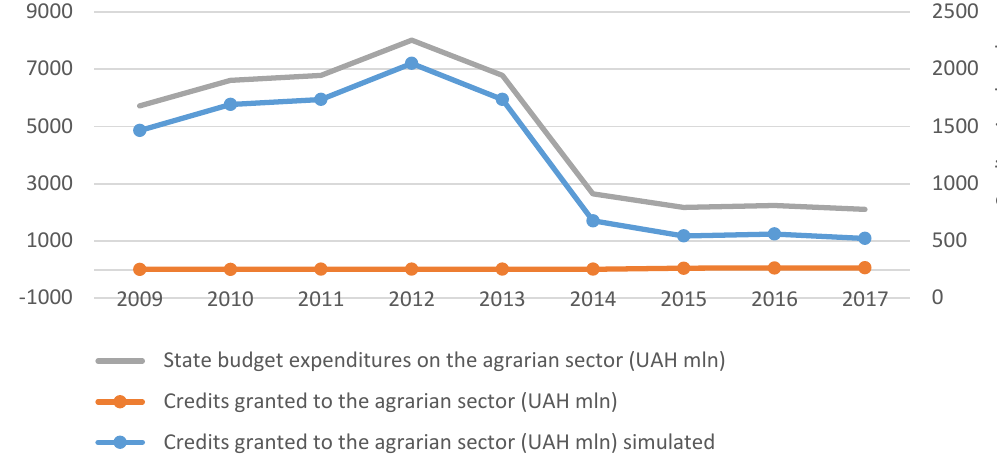
Figure 5. Dynamics of changes in the real and simulated levels of lending to agriculture as to public sector